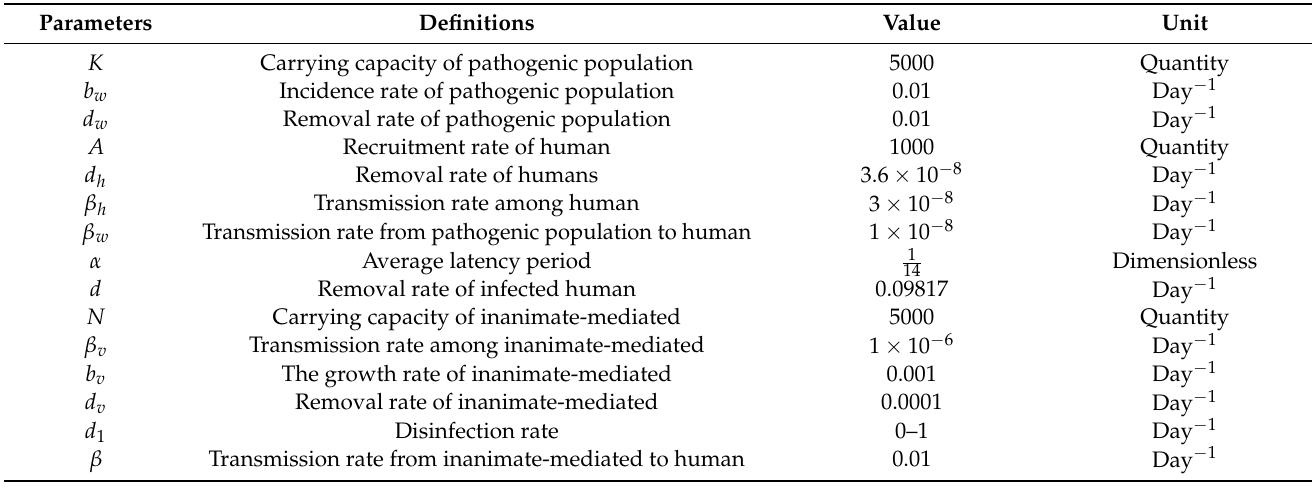
Table 1. The parameters in models.